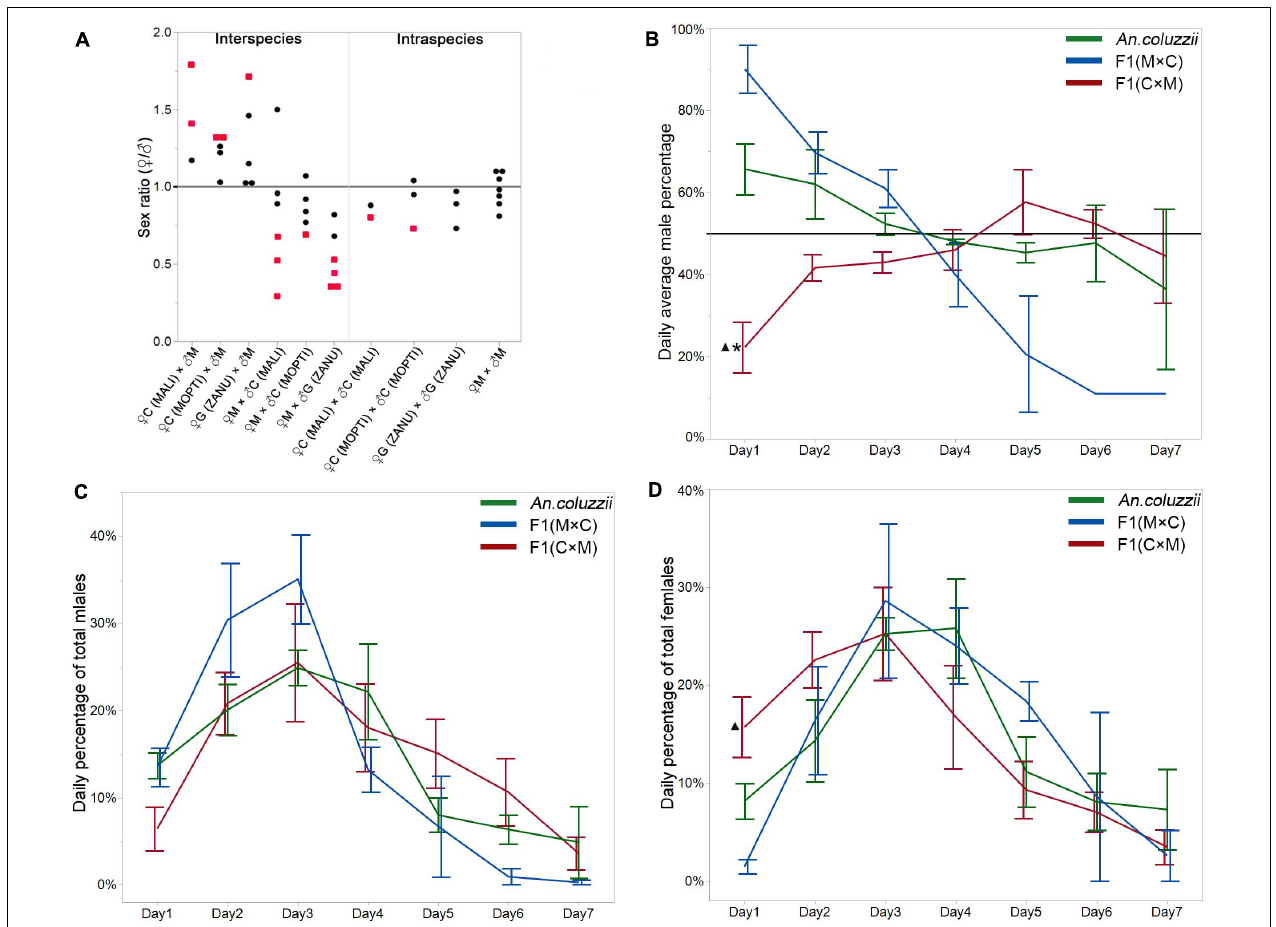
FIGURE 1 | Sex ratios and daily percentages of each sex in the intra-and inter-species crosses. (A) Female-to-male sex ratios in the F1 generations from the inter- and intra- species crosses. Each dot represents the sex ratio value from a single cross. Red dots indicate statistically significant deviations from a sex ratio of 1. (B) Daily average percentage of male pupae in the F1 generations from inter- and intra-species crosses when newly appeared line indicates a male percentage of 50%. (C) Daily average percentage of total males when the percentage of males for all 7 days combined = 100%. (D) Daily average percentage of total females when the percentage of females for all 7 days combined = 100%. *indicates statistical significance of data from the inter-species cross compared to pure species. (cid:78) indicates statistical significance of data from the inter-species cross compared to the reciprocal inter-species cross. M,